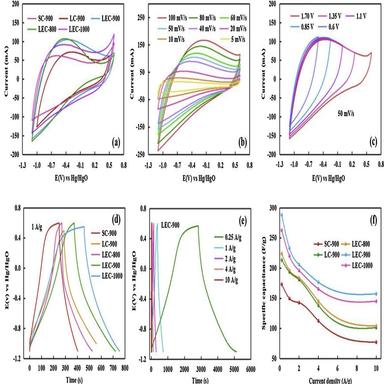
(a) CV curves obtained at scan rates of 50 mV/s for various samples; (b) CV curves of the LEC-900 sample at scan rates ranging from 5 to 100 mV/s; (c) CV curves of the LEC-900 sample acquired at operating voltages of 0.6 to 1.7 V using a scan rate of 50 mV/s; (d) GCD data for the specimens; (e) GCD data obtained at different current densities; and (f) specific cell capacitance values as functions of the current density.